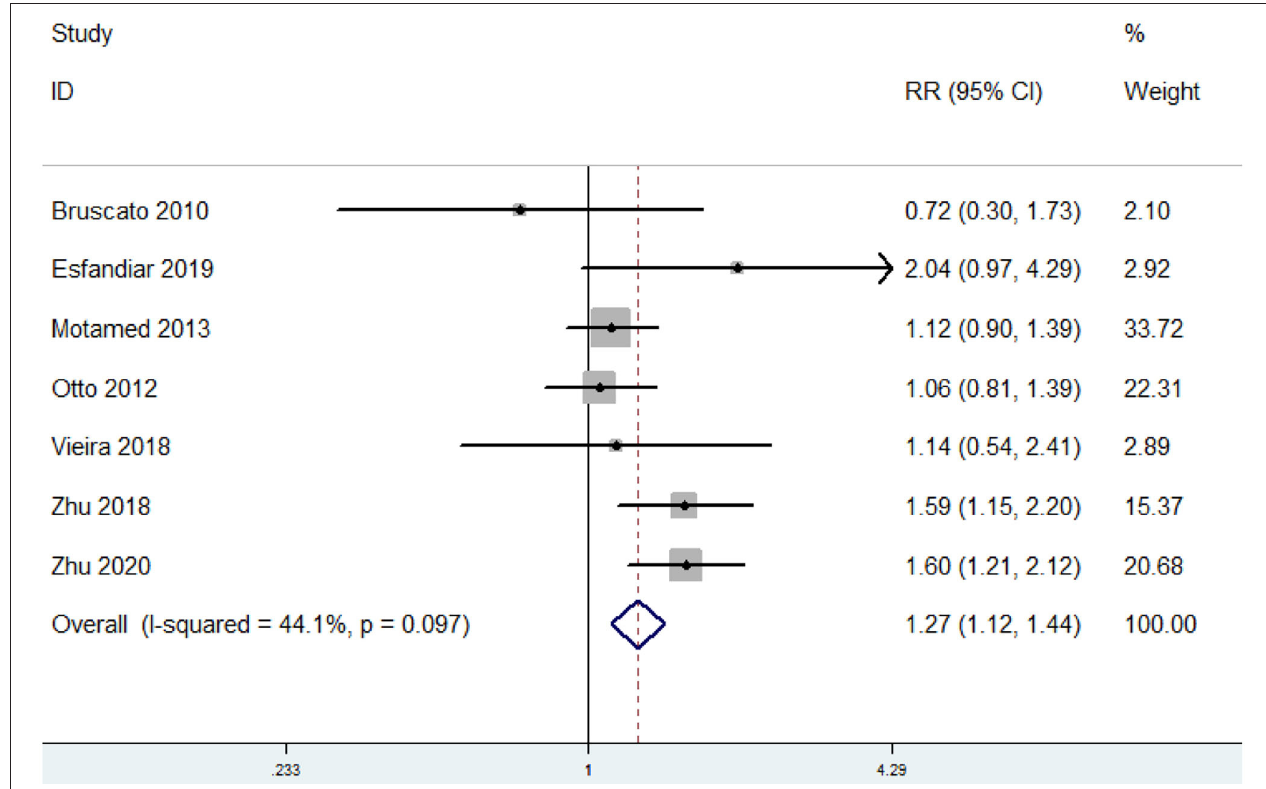
FIGURE 2 | Forest plot of meta-analysis: Overall multi-variable adjusted RR of MetS for the highest vs. lowest dietary iron level.